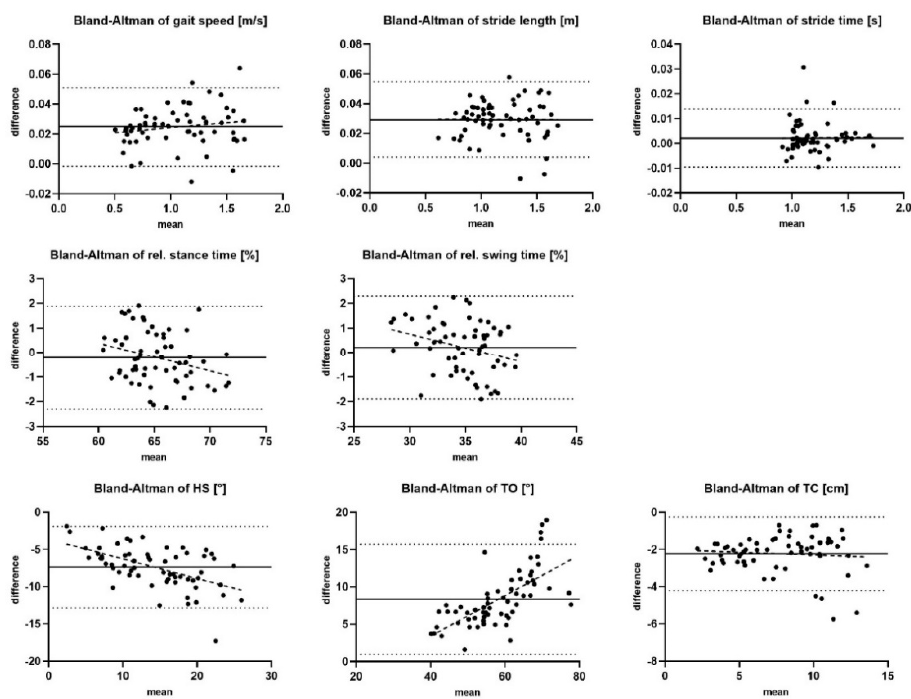
Figure 2. Difference between MGL and MC (bias = bold line) and ± 1.96 std (dotted line) presented with Bland–Altman plots of all measured gait parameters. Table 4. Group comparison of MGL and MC and effect size (r) compared between patients subdivided in H&Y stage 2, 3 and 4 (II, III, IV) and control group